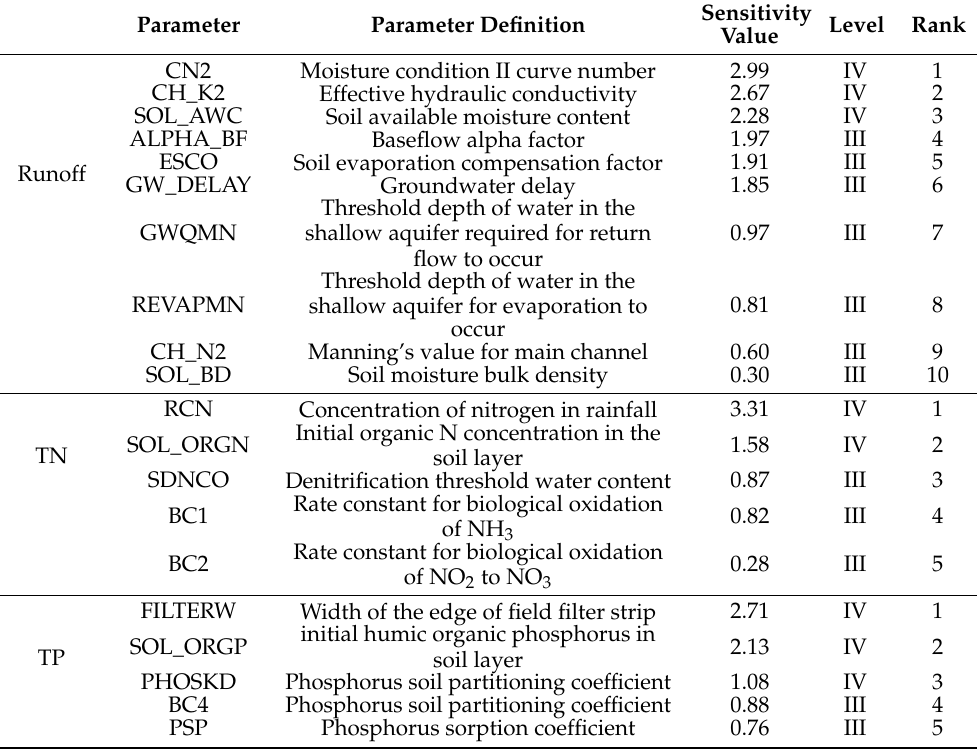
Table 1. The sensitivity value, sensitivity level, and sensitivity rank of principal parameters which related to runoff, total nitrogen (TN), and total phosphorus (TP)